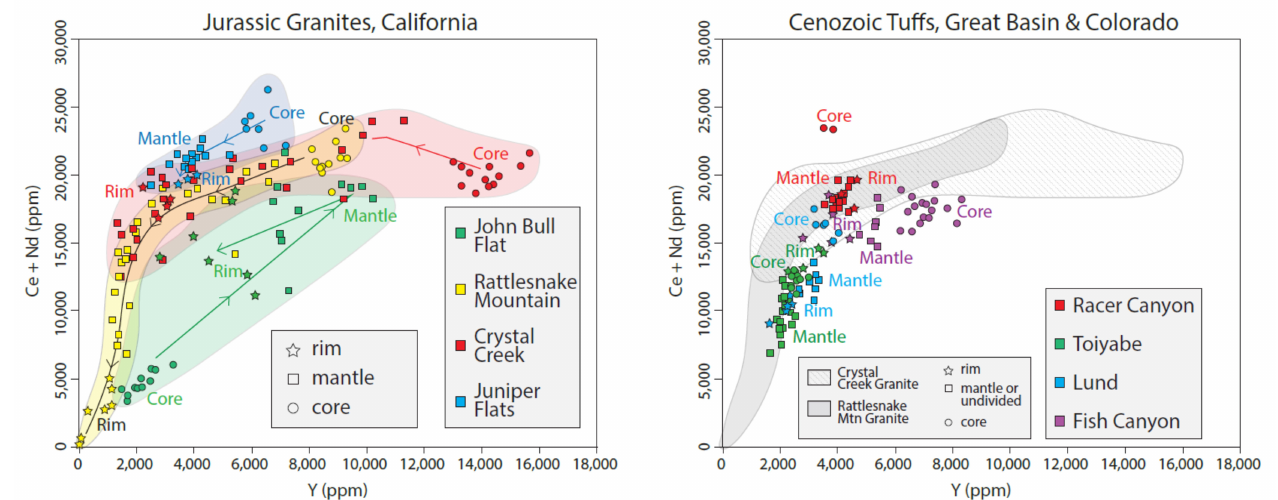
Figure 13. Ce + Nd versus Y pathways from core to rim in titanite grains from Middle Jurassic plutons from the San Bernardino Mountains of southern California compared to the same core to rim paths for several Cenozoic tuffs from the Great Basin and Colorado. On the diagram for the Cenozoic tuffs, fields are also shown for two of the grains from the California granites for